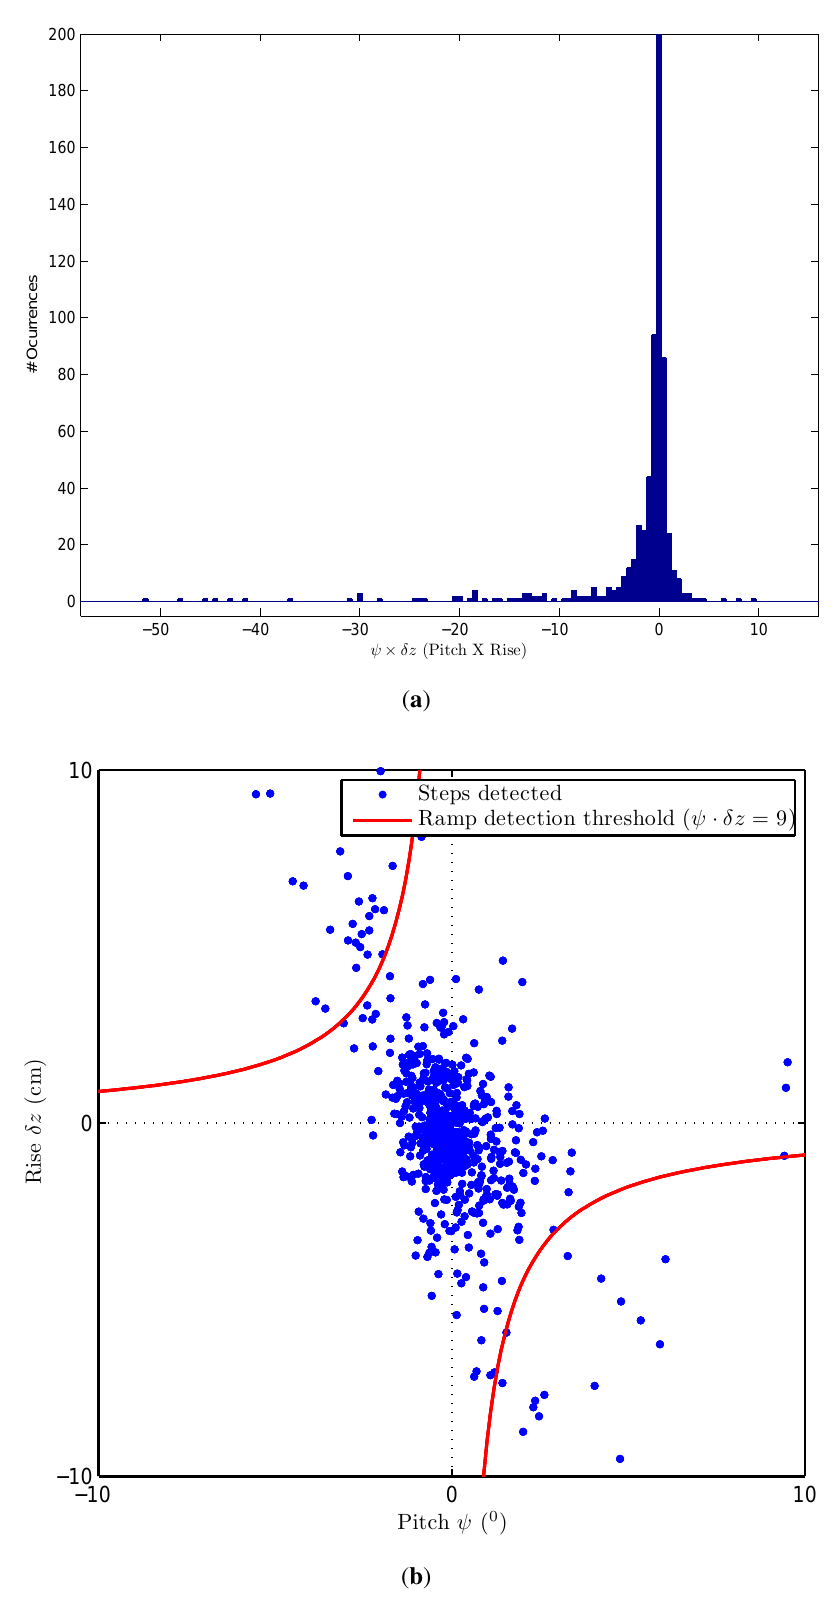
Figure 4. The metric to detect ramps ( · ∆ z , Pitch multiplied by Rise): ( a ) Histogram of the metric for a total of 696 steps, and ( b ) Distribution of all detected steps on a Pitch versus Rise plot (the threshold 9 degrees · cm, used for ramp detection, is